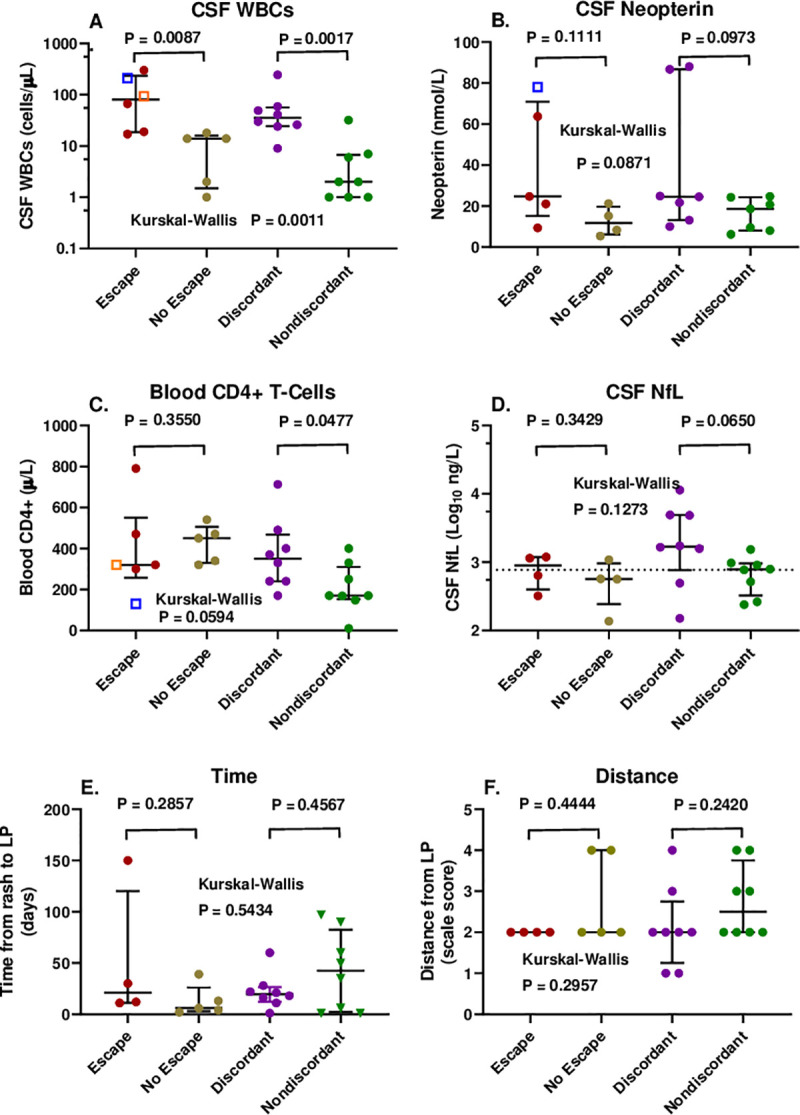
Comparisons of six variables among the four subject groups.Symbol colors are the same as in Fig 1 above. A. CSF WBC counts with escape group including the 2 non-HZ infections; B. CSF neopterin concentrations with escape group including the HSV-2 encephalitis; C. blood CD4+ T cell counts with escape group including the 2 non-HZ infections; D. CSF NfL concentrations in HZ; E. Time from outbreak of HZ rash to LP; and F. scaled distance from HZ eruption to LP site. Error bars show medians and interquartile ranges. The statistical comparisons shown are between the treated (escape and no escape) and untreated (discordant and nondiscordant) group pairs by Mann-Whitney test.